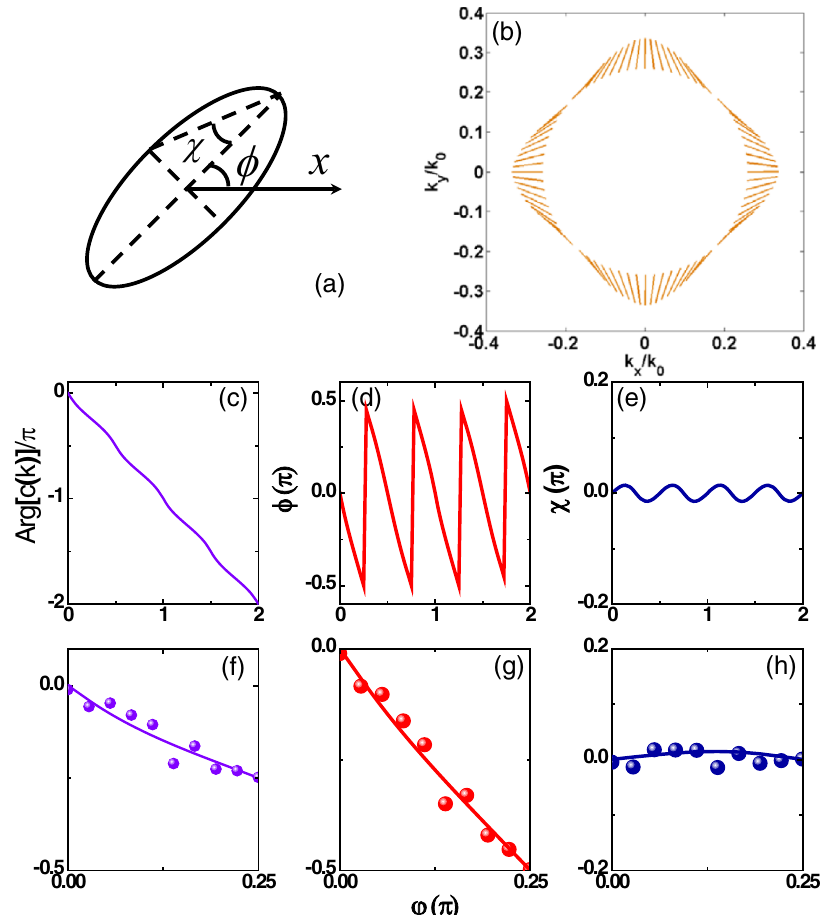
Fig. 4 Polarization vortex of the BIC. a General schematic of the polarization ellipse χ and polarization angle ϕ . Direction of the polarization vector c(k) ( b ), angle of the polarization vector arg ½ c ð k Þ(cid:2) ( c , f ), polarization angle ϕ ( d , g ), and polarization ellipses χ ( e , h ) in momentum space for θ ¼ 15 o at the frequency of the 2nd BIC in the azimuthal direction. Solid lines illustrate the numerical results and the scatter points show the measured